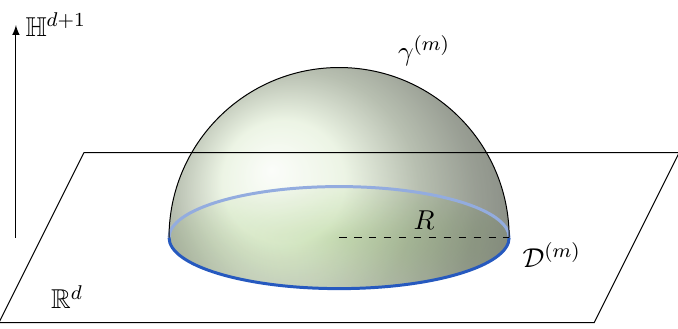
Figure 5 . A totally geodesic submanifold in H d +1 that is anchored on a conformal defect in R d